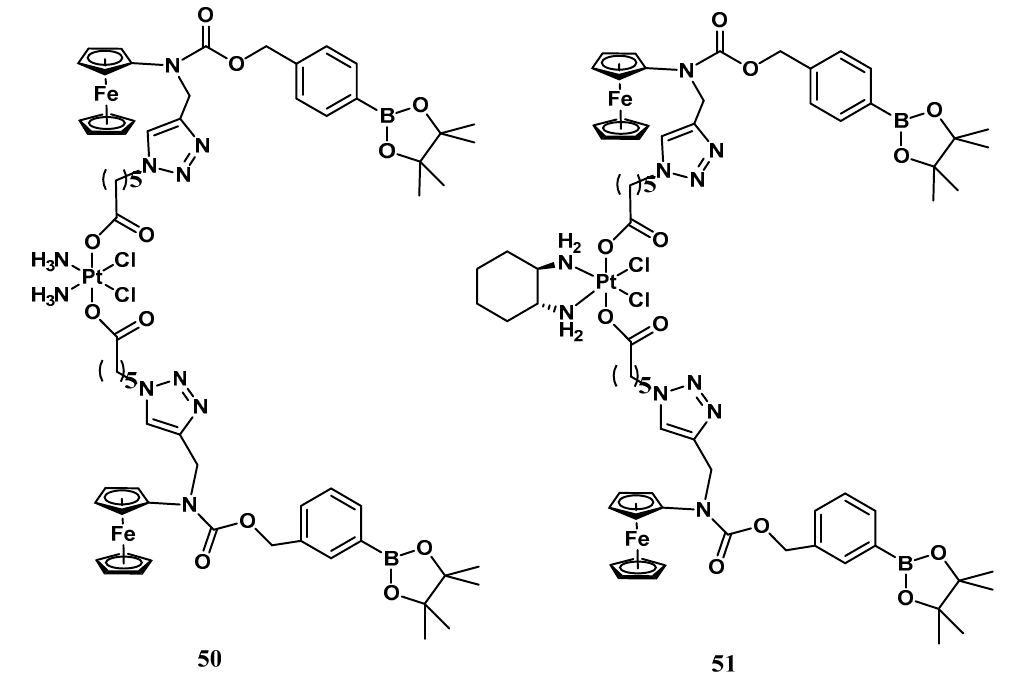
Figure 18. ROS-activated Pt(IV) complexes, 50 and